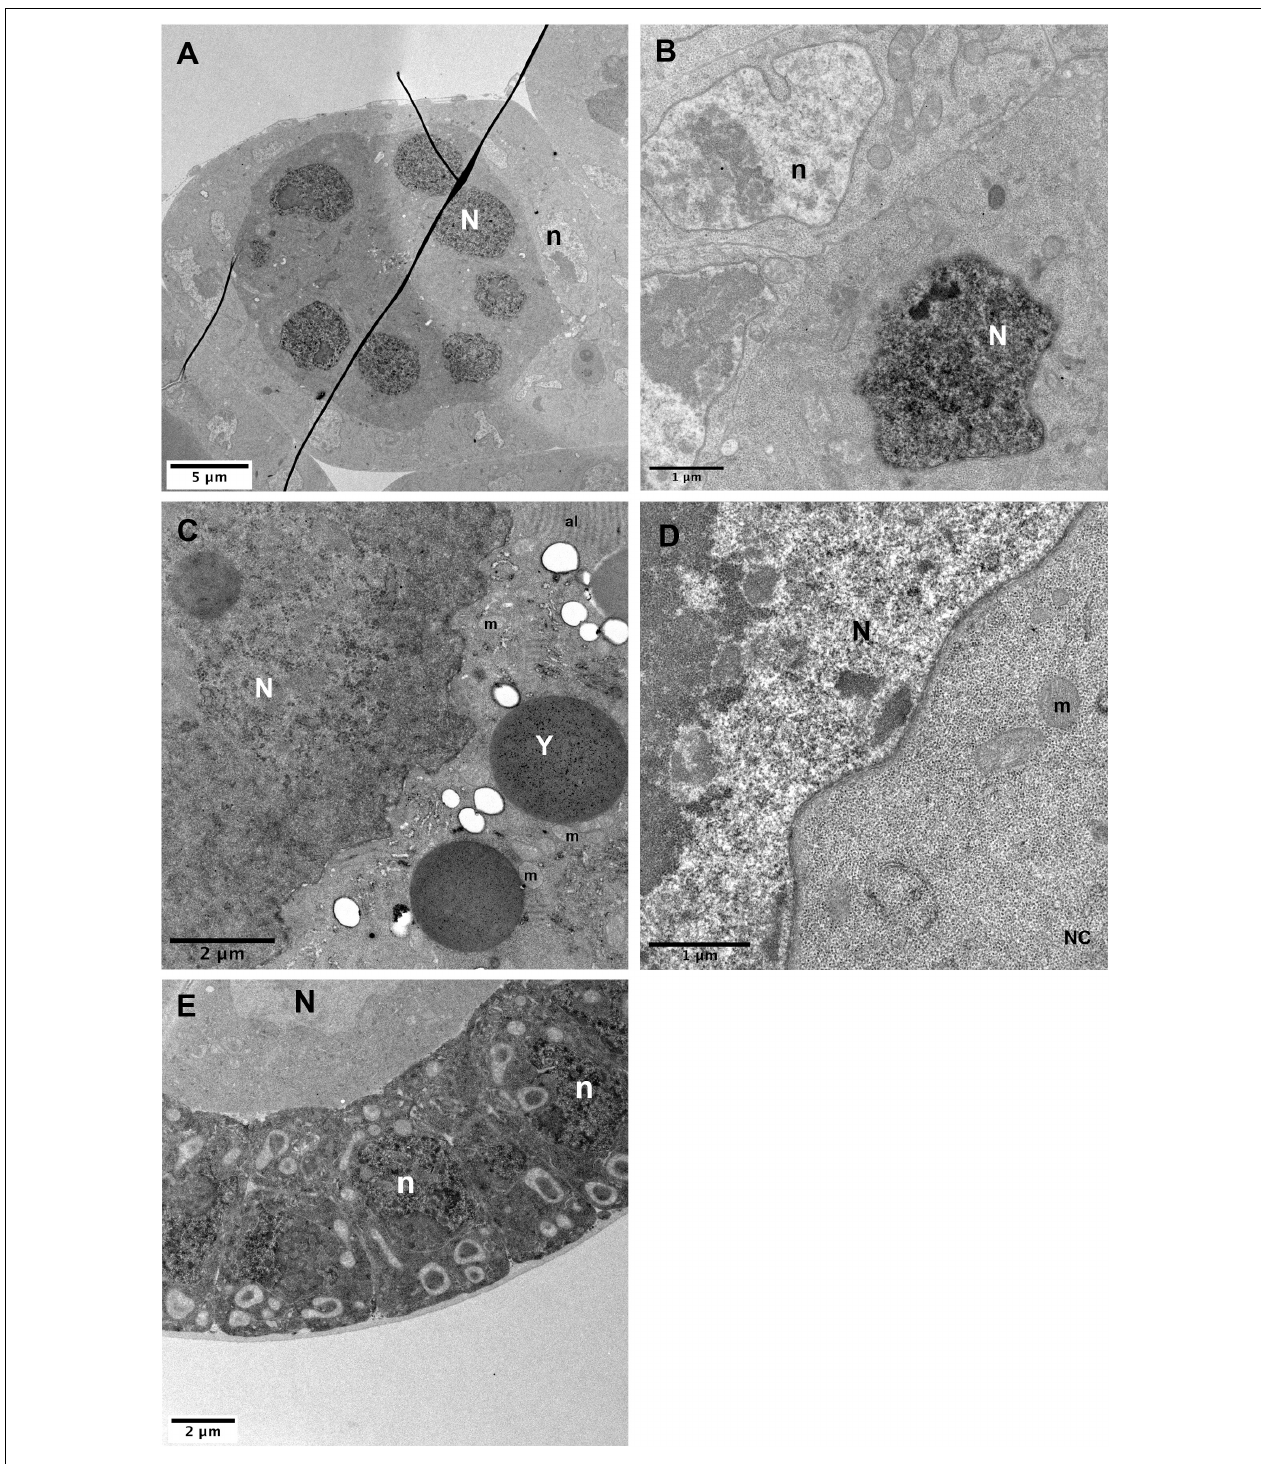
FIGURE 6 | Nuclear detection of APEX2. (A–C) In hsp-flp ; FRT79D ubi-nlsGFP/nos-GAL4 VP 16 , UAS-APEX2-GBP follicles, strong DAB staining is observed in germline nuclei (N) [ (A) , higher magnifications in panels (B,C) ]. (D) Control sample without the APEX2-GBP transgene exhibits a strong difference between the contrasts of the nucleus that is lighter than the cytoplasm. Comparison of the contrasts between panels (C,D) clearly shows that the stronger signal in the nucleus of hsp-flp ; FRT79D ubi-nlsGFP/nos-GAL4 VP 16 , UAS-APEX2-GBP ovarian follicles is specific. (E) In hsp-flp ; Tj-GAL4 ; FRT79D ubi-nlsGFP/UAS-APEX2-GBP , nuclei of the follicular cells display strong accumulation of DAB precipitates. (N) germline nuclei, (n) follicle cells nuclei, (Y) yolk vesicle, (m) mitochondria, (al) annulate lamellae. Number of observations (A–C) : ( n = 5), (D) ( n = 2), (E) ( n = 2).